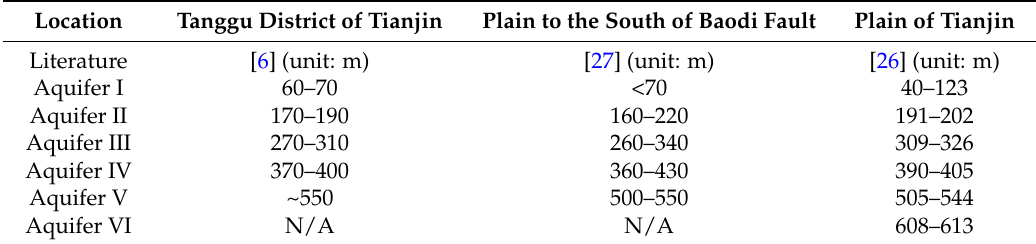
Table 1. Bottom depth of aquifers in Tianjin. Baodi fault and Plain of Tianjin are depicted in Figure 1a. Tanggu district is shown in Figure